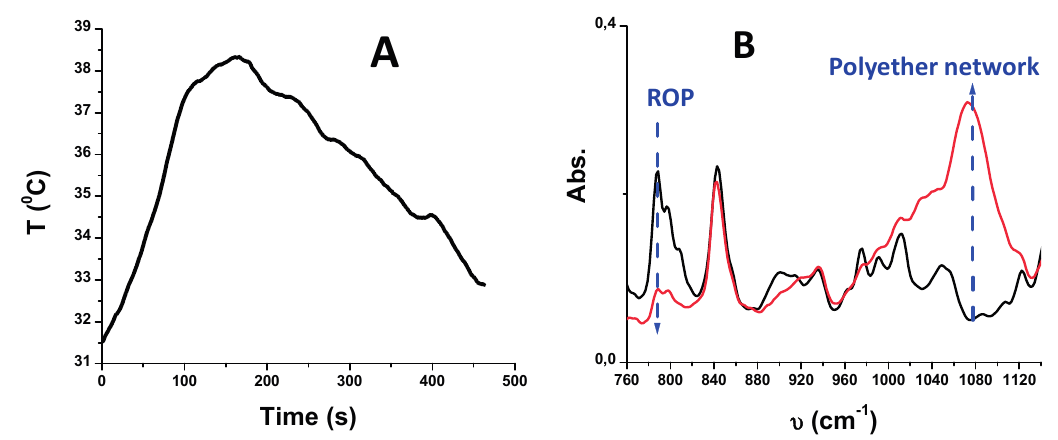
Figure 4. ( A ) Role of the monomer in the thermal free radical polymerization of EPOX under air in the presence of DPSi/NVK/AgSbF 6 (2%/2%/1% w/w ). ( B ) IR spectra recorded during the thermal cationic polymerization in the range between 760–1140 cm − 1 of sample containing 1% (wt) of AgSbF 6 , 2% (wt) of DPSi and 2% (wt) of NVK in EPOX ( 1 )